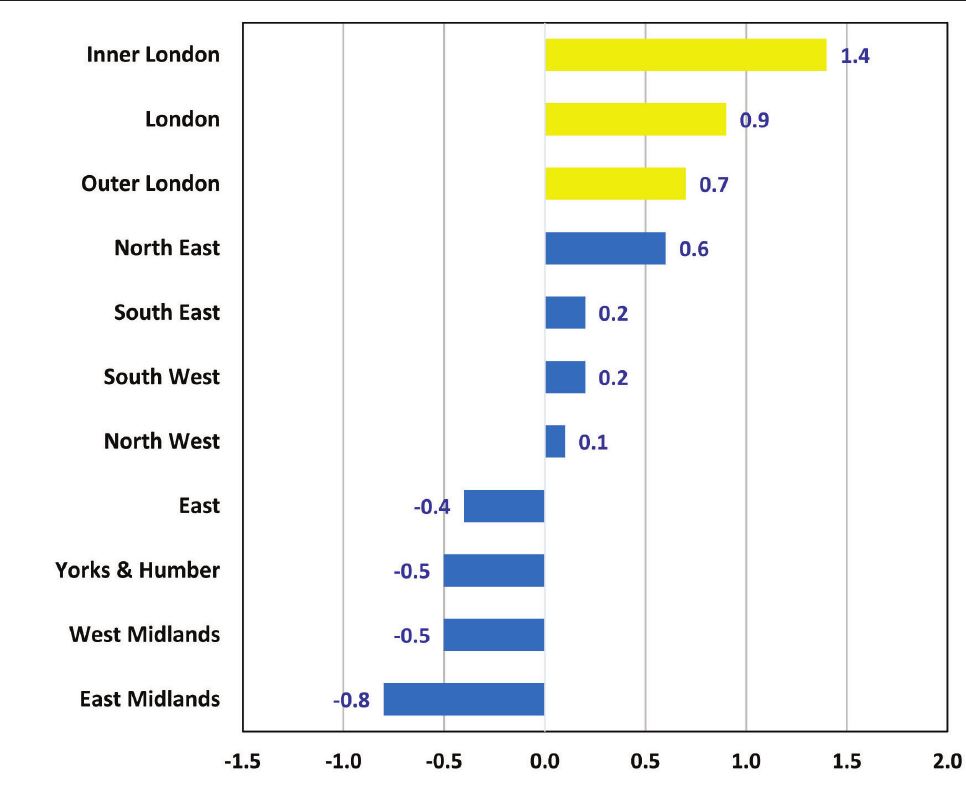
Figure 5: Key Stage 2 progress scores in reading by English region in 2016 Figure 5 indicates that Inner and Outer London had the highest positive progress scores of all English regions, with the North East close behind and considerably ahead of the other regions. Although not illustrated here, the same pattern was shown in the writing and mathematics progress scores, with London pre-eminent in all three subjects and the North East again the next highest performing region in these